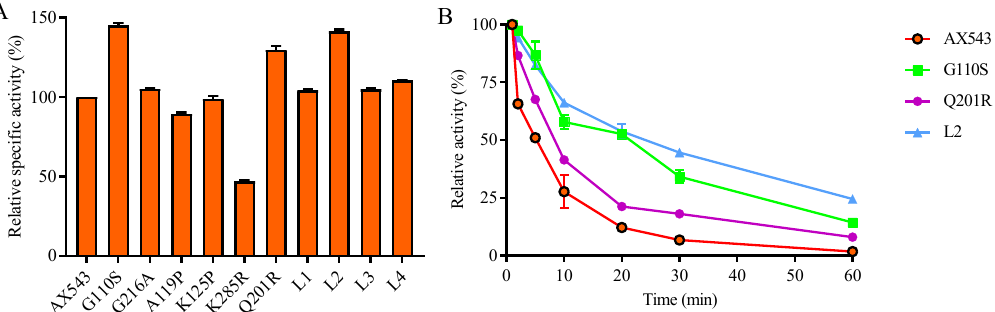
Figure 3. The relative specific activities (A) and thermostability (B) of purified xylosidase AX543 and their mutations. Figure 3. The specific activities ( A ) and thermostability ( B ) of the wild-type AX543 and its variants. Compared with thermophilic xylosidases Xyl43A and PtXyl43, AX543 has a higher glycine ratio than Xyl43A and PtXyl43, and AX543 contains extra glycine at the 110 and 216 sites (Figure 4). Moreover, the ratio of proline in AX543 is lower than in Xyl43A and PtXyl43 (Table 2), the corresponding site of 119 A of AX543 is proline 123P in Xyl43A, and the corresponding site of 125 K of AX543 is proline 129 P in PtXyl43 (Figure 4). Further- more, as shown in Table 2, the number of total hydrogen bonds and arginine-mediated hydrogen bonds of AX543 were less than that of high temperature xylosidase Xyl43A. The arginine/lysine ratio of AX543 is also lower than that of Xyl43A and PtXyl43. It was determined that the corresponding site of 201 in AX543 is arginine in Xyl43A, and the corresponding site of 285 in AX543 is also arginine (Figure 4).